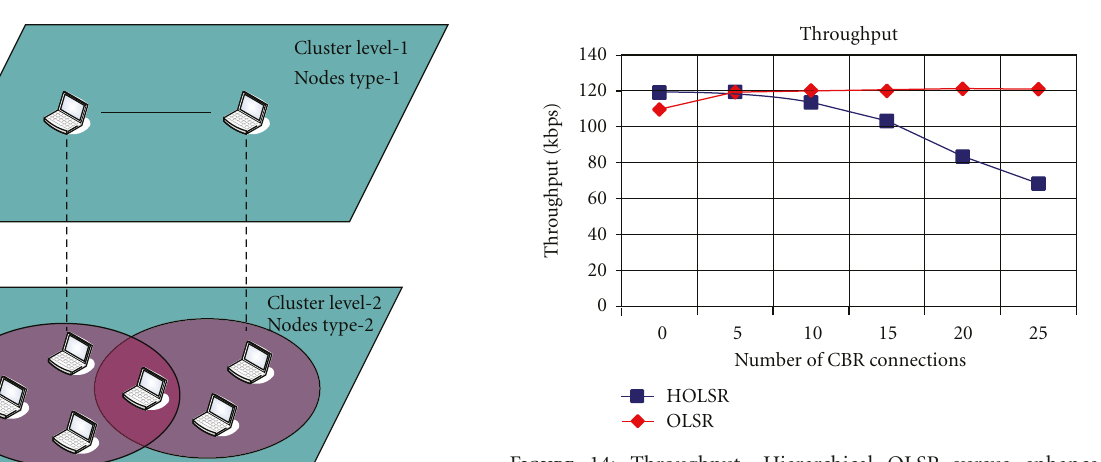
Figure 14: Throughput—Hierarchical OLSR versus enhanced